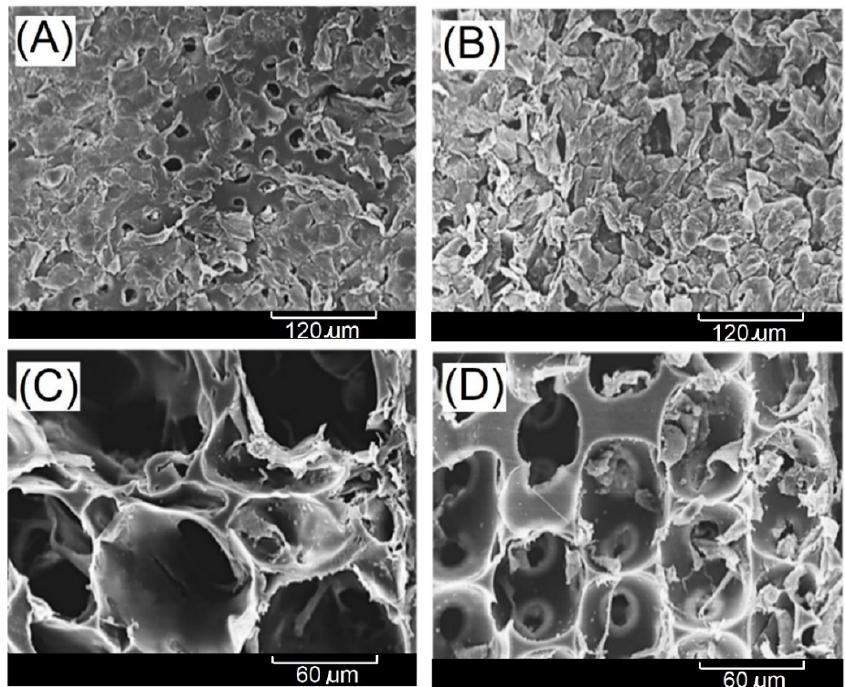
Figure 9. Scanning electron microscope analysis of static culturing chondrocytes on EDC-crosslinked gelatin-based hydrogel scaffolds, ( A ) after 7 days (100 μ m) (surface, scale bar = 120 μ m), ( B ) after 7 days (160 μ m) (surface, scale bar = 120 μ m), ( C ) after 14 days (100 μ m) (cross section, scale bar = 60 μ m), and ( D ) after 14 days (160 μ m) (cross section, scale bar = 60 μ m).